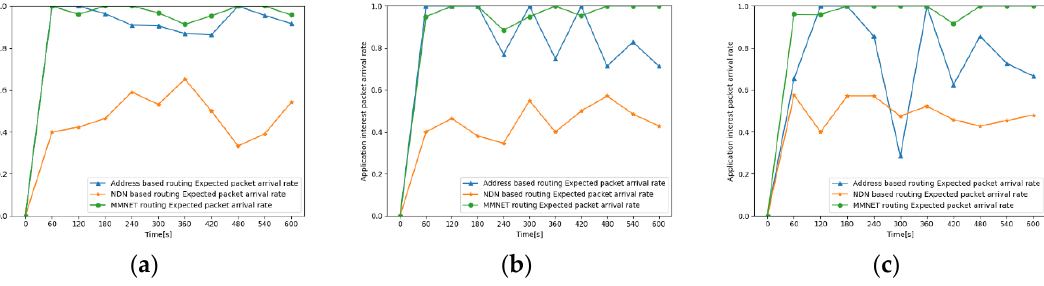
Figure 20. ( a ) Application expected packet arrival rate of three collection nodes; ( b ) application expected packet arrival rate of six collection nodes; ( c ) application expected packet arrival rate of nine collection nodes.